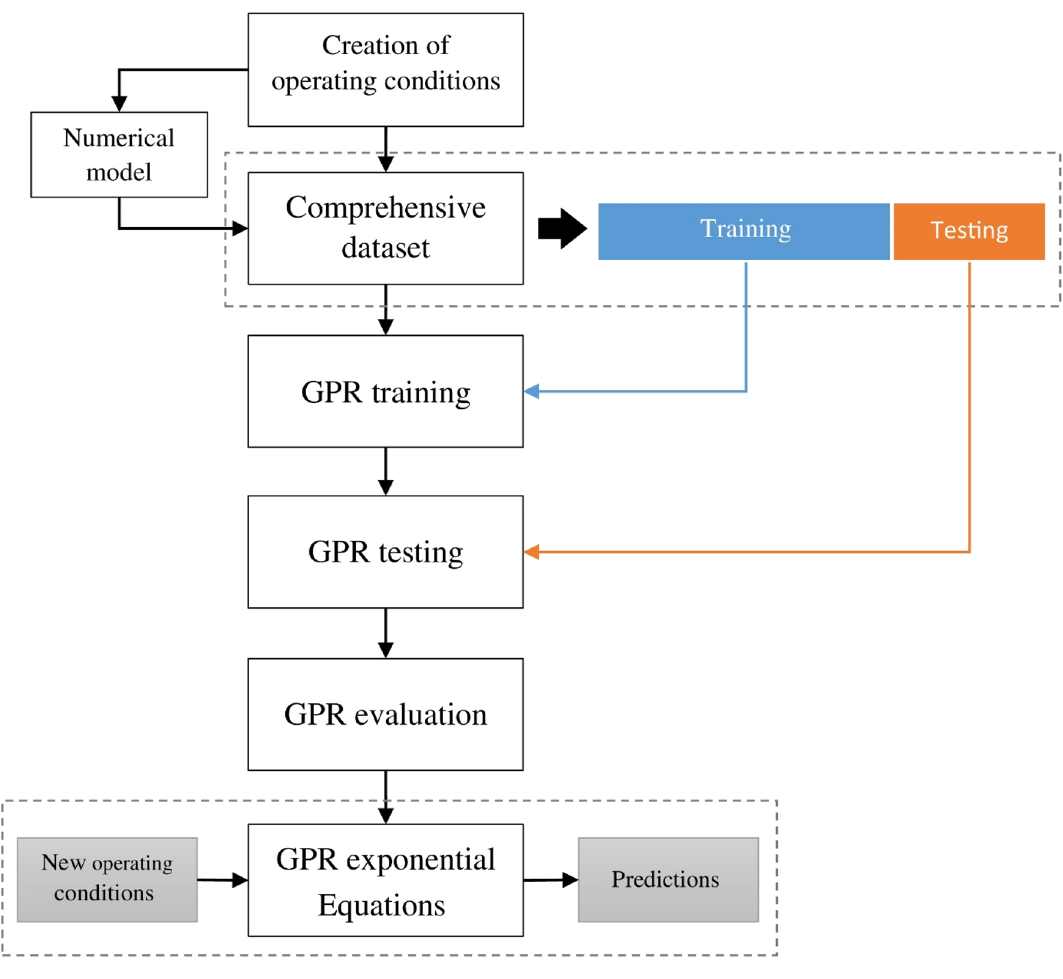
Figure 1. Flowchart for GPR